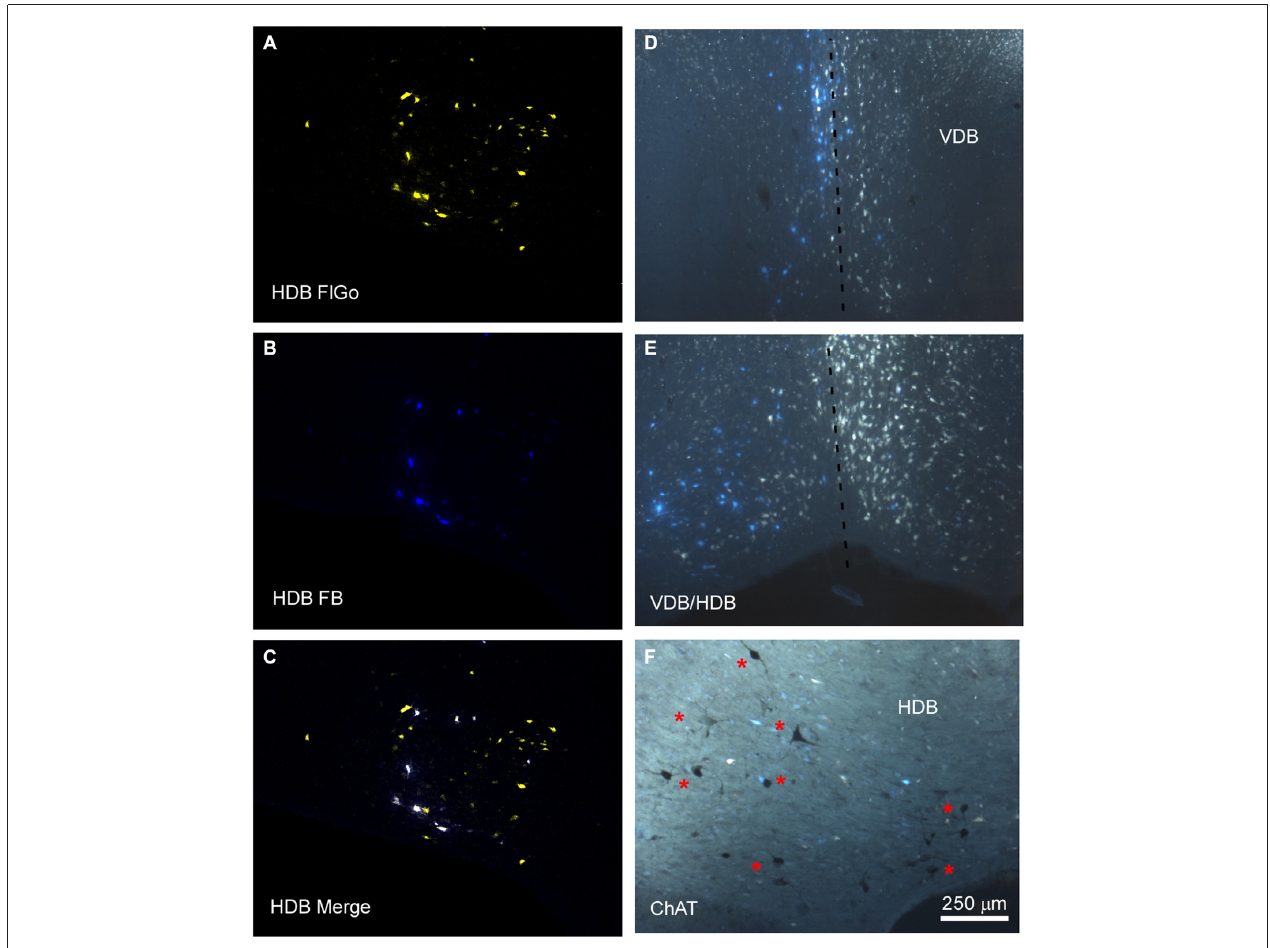
FIGURE 2 | Distribution of labeled neurons in the VDB/HDB. (A–C) Confocal microscope images of retrogradely FlGo (S1 injection) and FB (A1 injection) labeled neurons in the VDB/HDB; (D,E) fluorescence microscope images of both Fluoro Gold and Fast Blue labeled neurons in the VDB and HDB. Note that some neurons project to both cortical areas. Dashed line indicates the medial hemispheric line. (F) Image combining fluorescent microscopy with acetylcholine transferase (ChAT) immunocytochemistry techniques in HDB. Asterisks indicates cholinergic neurons. HDB, nucleus of the horizontal limb of the diagonal band; VDB, nucleus of the vertical limb of the diagonal band. Calibration toolbar for (A–F) 250 µ